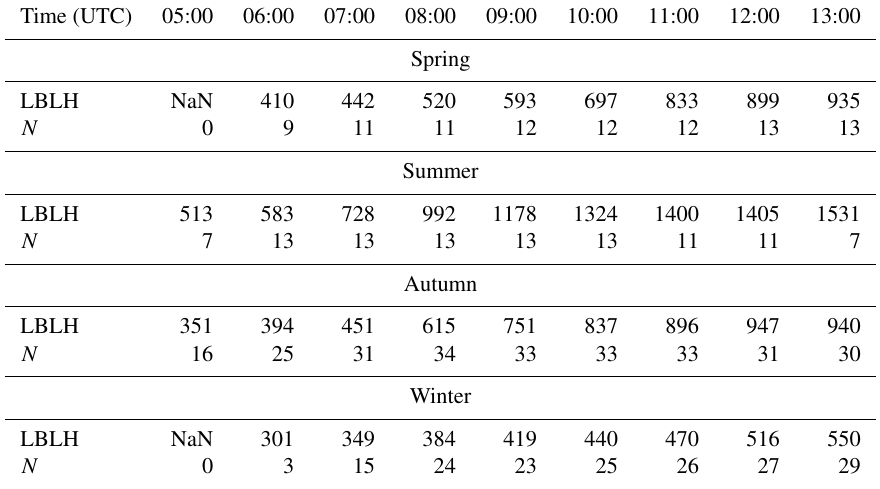
Table 4. Mean altitude of the lowest estimate of the boundary layer height (LBLH) by season in the morning and early afternoon (hours are given in UTC; altitude in ma.g.l.). The number of points used to calculate the means are also given ( N ). NaN indicates no available